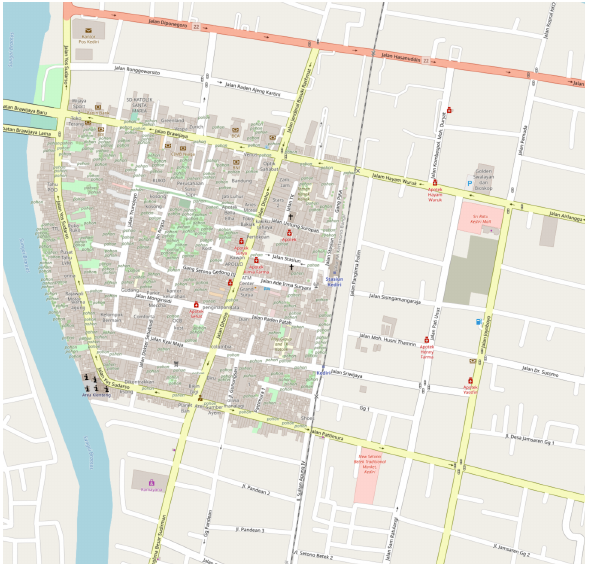
Figure 6. Highly heterogeneous mapping completeness in the town Kediri, Indonesia, suggesting that this research is more meaningful on the neighbourhood-scale.